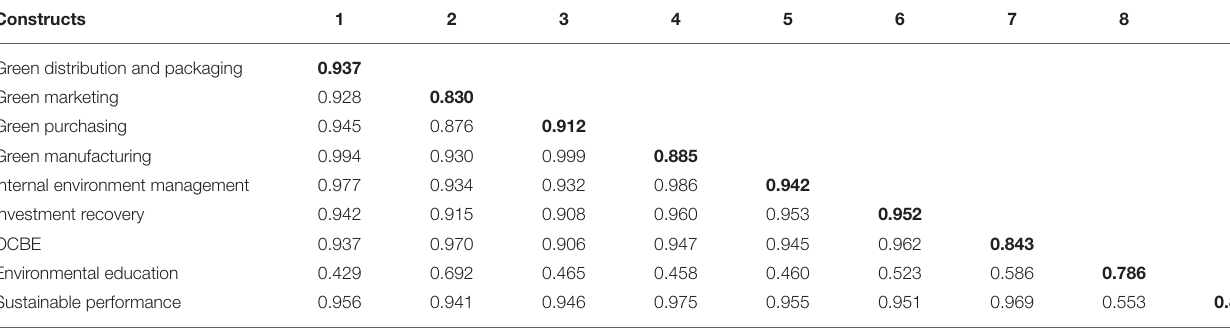
TABLE 2 | Discriminant validity.